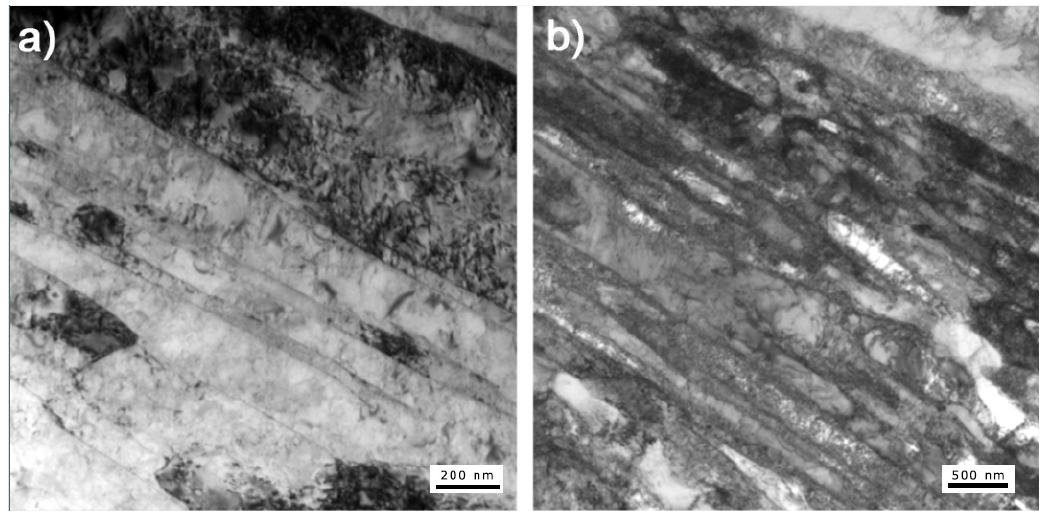
Figure 10. TEM electron micrographs of Heat A after single tempering treatment at: ( a ) 620 °C and ( b ) 680 °C.